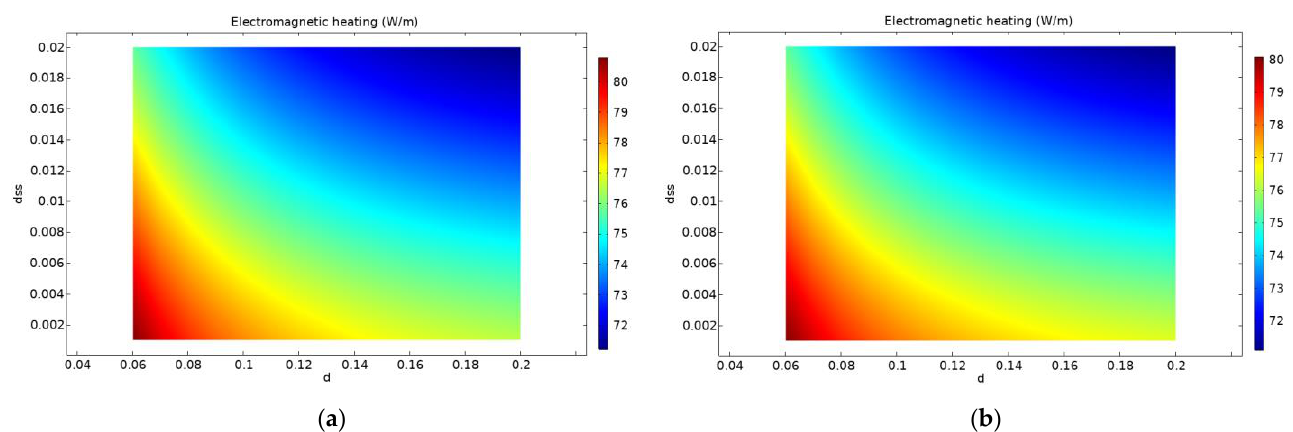
Figure 9. Electromagnetic heating against the distance between busbars of the same phase and phase-to-phase distance at 60 Hz for: ( a ) Model 3; ( b ) Model 4.